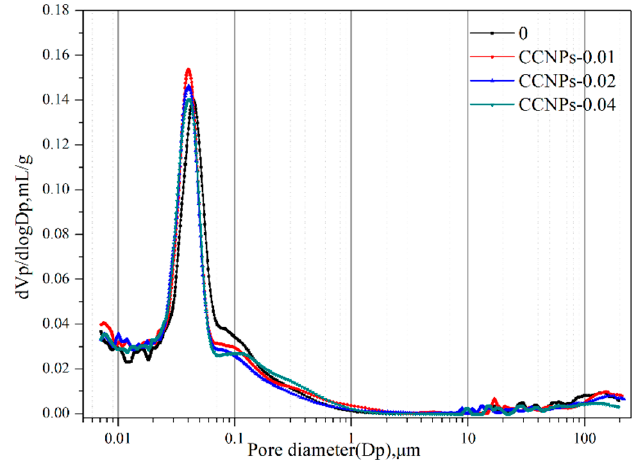
Figure 6. Pore size Distribution of CCNPs composite cement pastes.